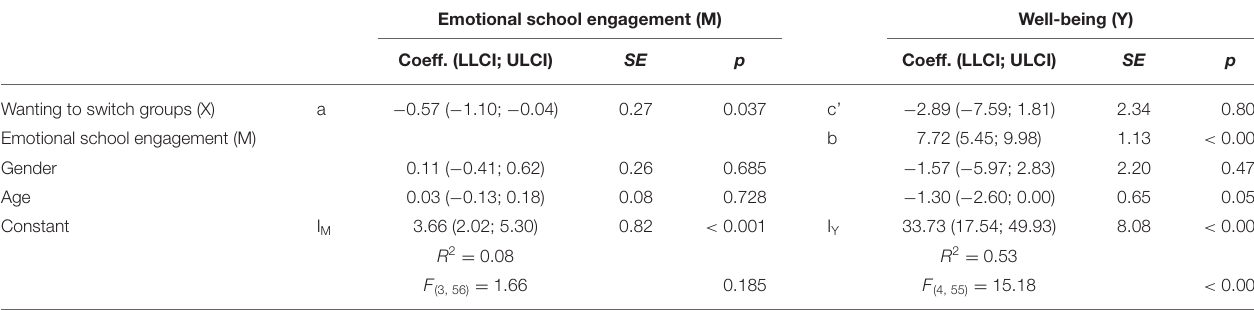
TABLE 2 | Mediation model for the relationship of wanting to switch groups and well-being via emotional school engagement ( n = 60). Emotional school engagement (M) Well-being (Y) Coeff. (LLCI;